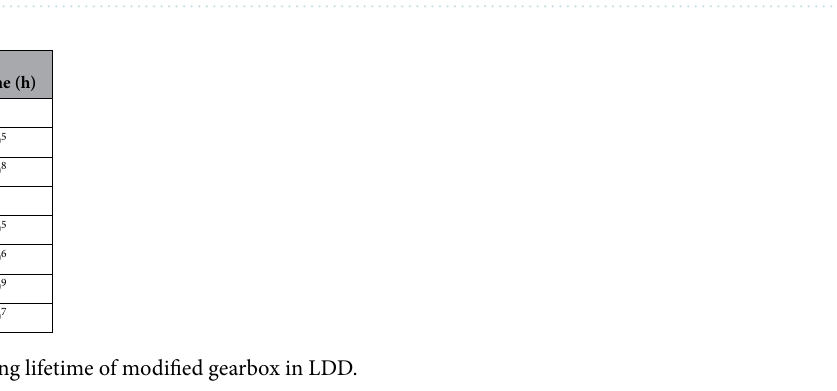
Figure 7. Face load distribution of SGS 1 on load level 8 for modified gearbox: ( a ) Pinion contact pattern and ( b ) gear contact pattern.